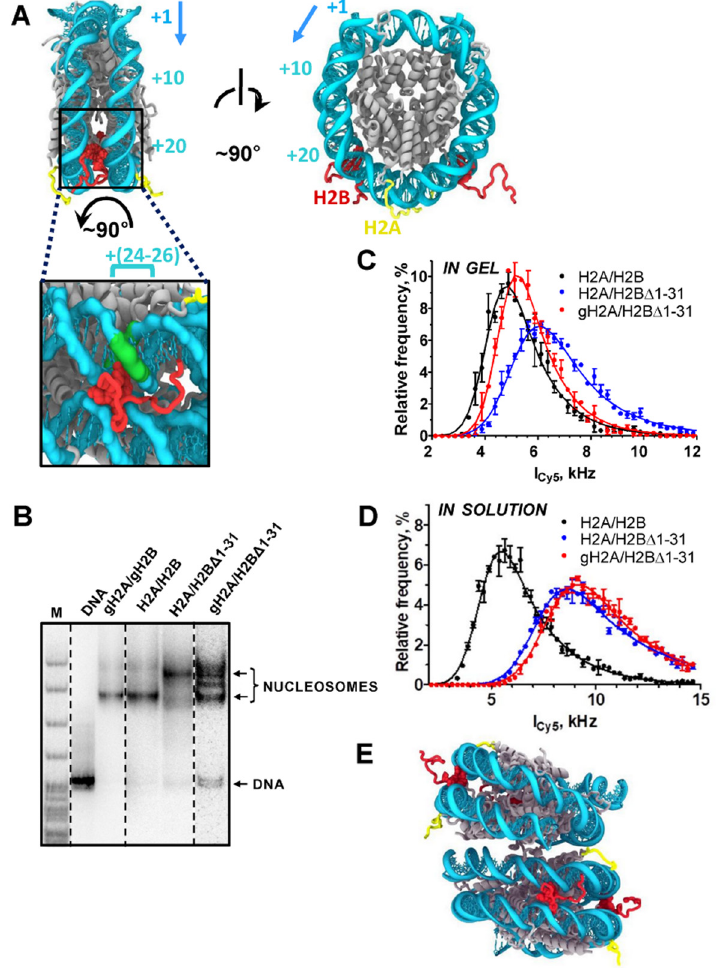
Figure 2. H2A tails mediate the interaction between the DNA gyres of neighboring nucleosomes. ( A ) Locations of H2B and H2A N-terminal tails in the nucleosome core particle (PDB 1KX5, lateral and side views). DNA is colored in cyan, histones—in grey, H2B N-terminal tails (positions 1–31)—in red, H2A N-terminal tails (position 1–12)—in yellow. H3 N-terminal tails are truncated for clarity. All atoms of the important KKRRK motif of the H2B tail (positions 27–31) are shown as van der Waals spheres. The H2B tail mediates the interaction between two DNA gyres within the same NCP. Histone H2B tails interact with nucleosomal DNA at the distance of ~25 bp (+25) from the nucleosomal boundary. Direction of transcription is indicated by an arrow. A zoom up view is provided with the DNA region +(24–26) highlighted in green. ( B ) Analysis of gel-purified nucleosomes by native PAGE. Nucleosomes contained intact H3/H4 histones and various variants of H2A/H2B histones. M: pBR322-MspI digest. ( C , D ) Distributions of single nucleosomal particles by fluorescence intensity (I Cy5 ) in gel ( C ) and in solution ( D ). ( E ) Location of H2A N-terminal tails in the crystal packing of nucleosome core particles (NCP, PDB 1KX5). Two NCPs stacked by their lateral surfaces are shown, with H2A N-tails mediating the interaction between the DNA gyres of neighboring NCPs. The color code is in panel ( A